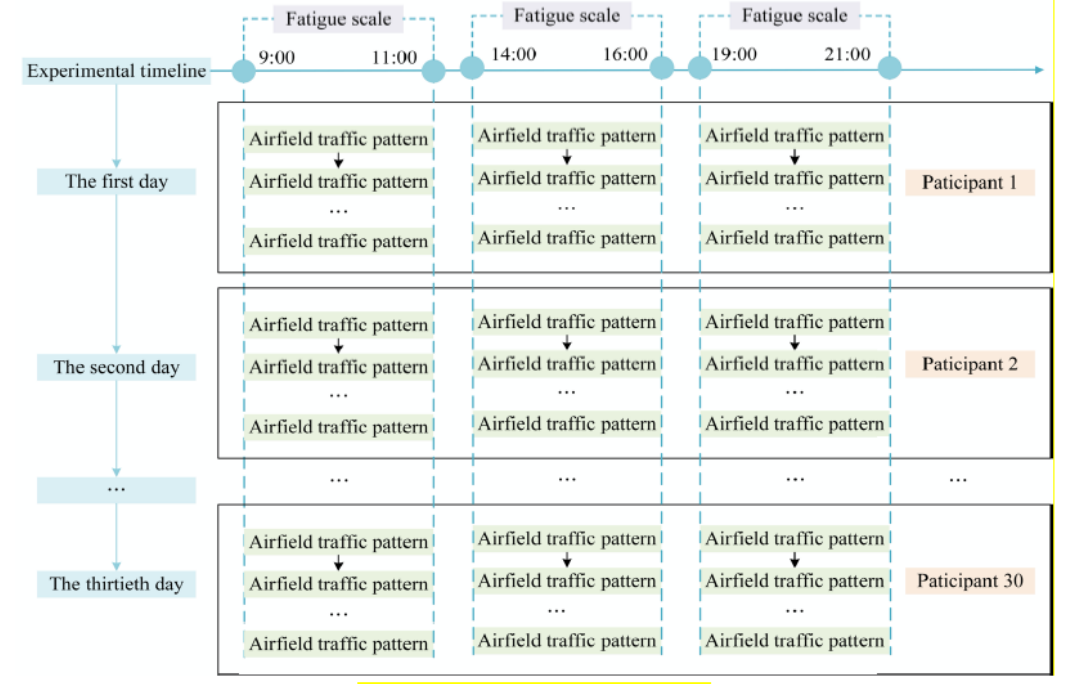
11 of 24 Figure 7. Schematic diagram of the pilot completing the airfield traffic pattern. 3.2.4. Experimental Process On the day before the experiment, the participants rested before 23:00 to ensure that